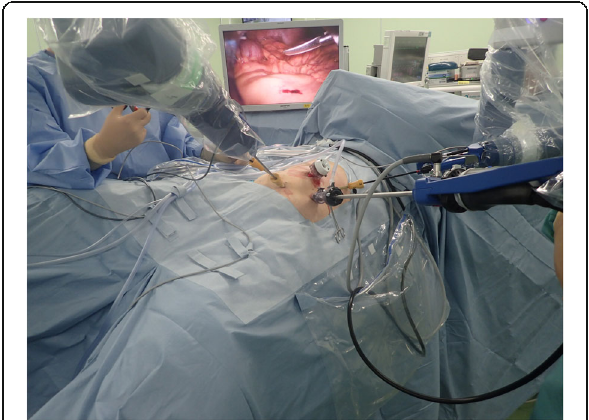
Fig. 3 Operative room installation — patient positioning on